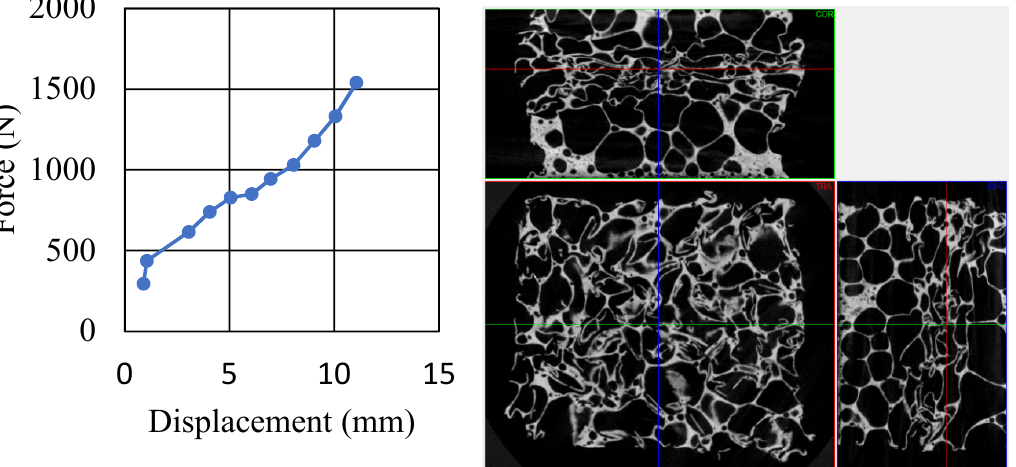
Figure 5. Force–displacement curve, showing the three orthogonal reconstructed slices (from Bruker’s Data Viewer software [51]) of a closed-cell foam (cross section: 15 mm × 15 mm).